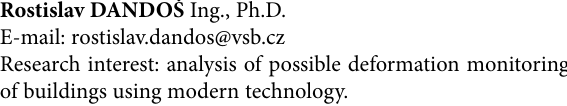
Table 6. Values of the differences in elevation between fixed points, Mír 5 shaft, Mine Darkov 1 st method